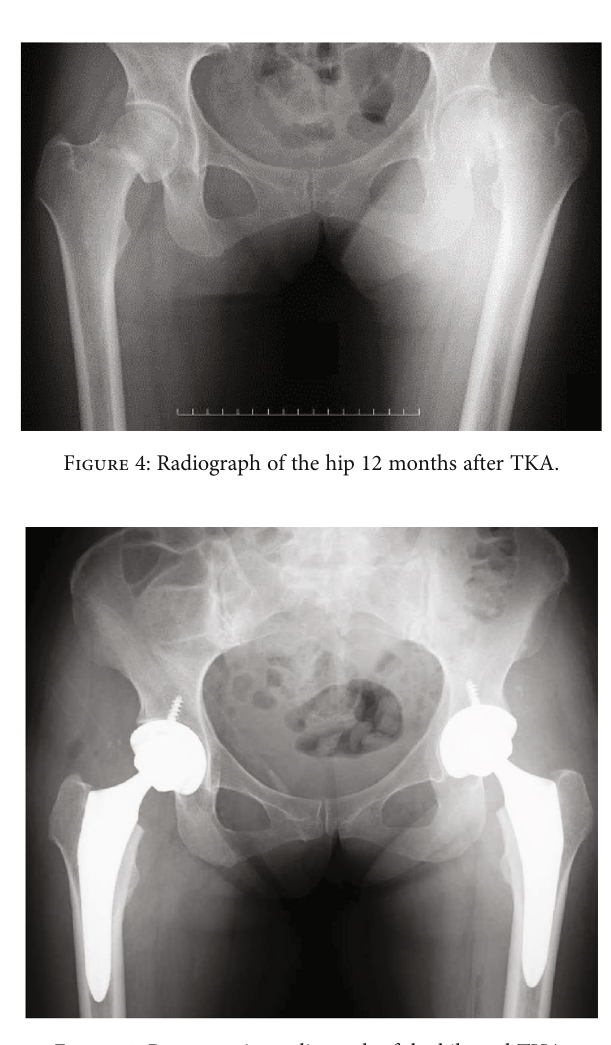
Figure 5: Postoperative radiograph of the bilateral THA.